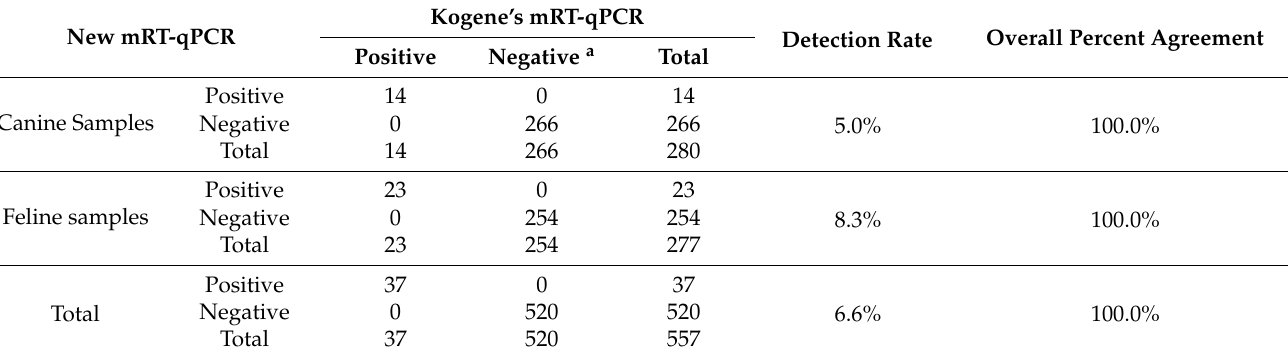
Table 4. Comparison of the results of the developed and Kogene’s mRT-qPCR assays for detecting SARS-CoV-2 in canine and feline clinical